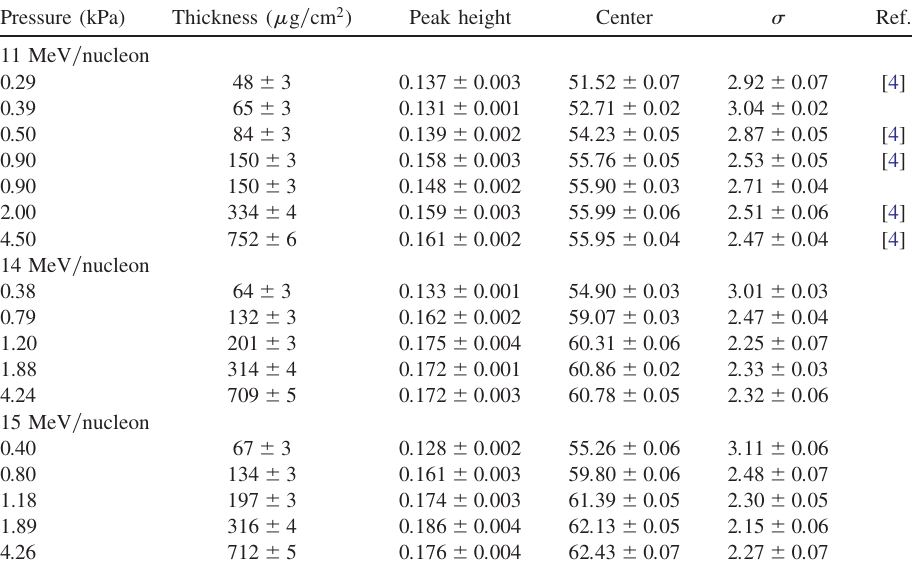
TABLE II. Fitting parameters of 238 U charge-state distributions using the N stripper. The listed errors are attributed to the fitting procedure. Previous results [4] are included in the list for 11 MeV = nucleon .